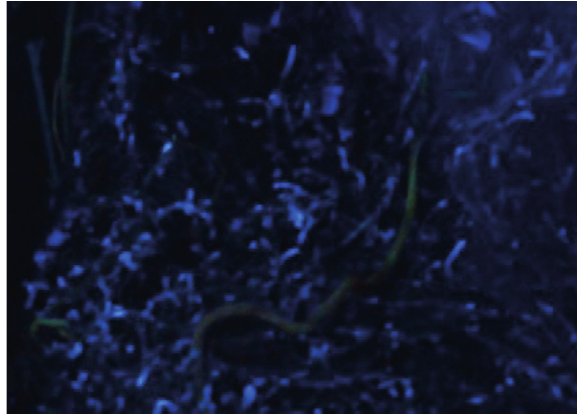
Figure 6 Root system of oat on a substrate with plant plastic from wheat husk without adhesives in ultraviolet light with luminescence